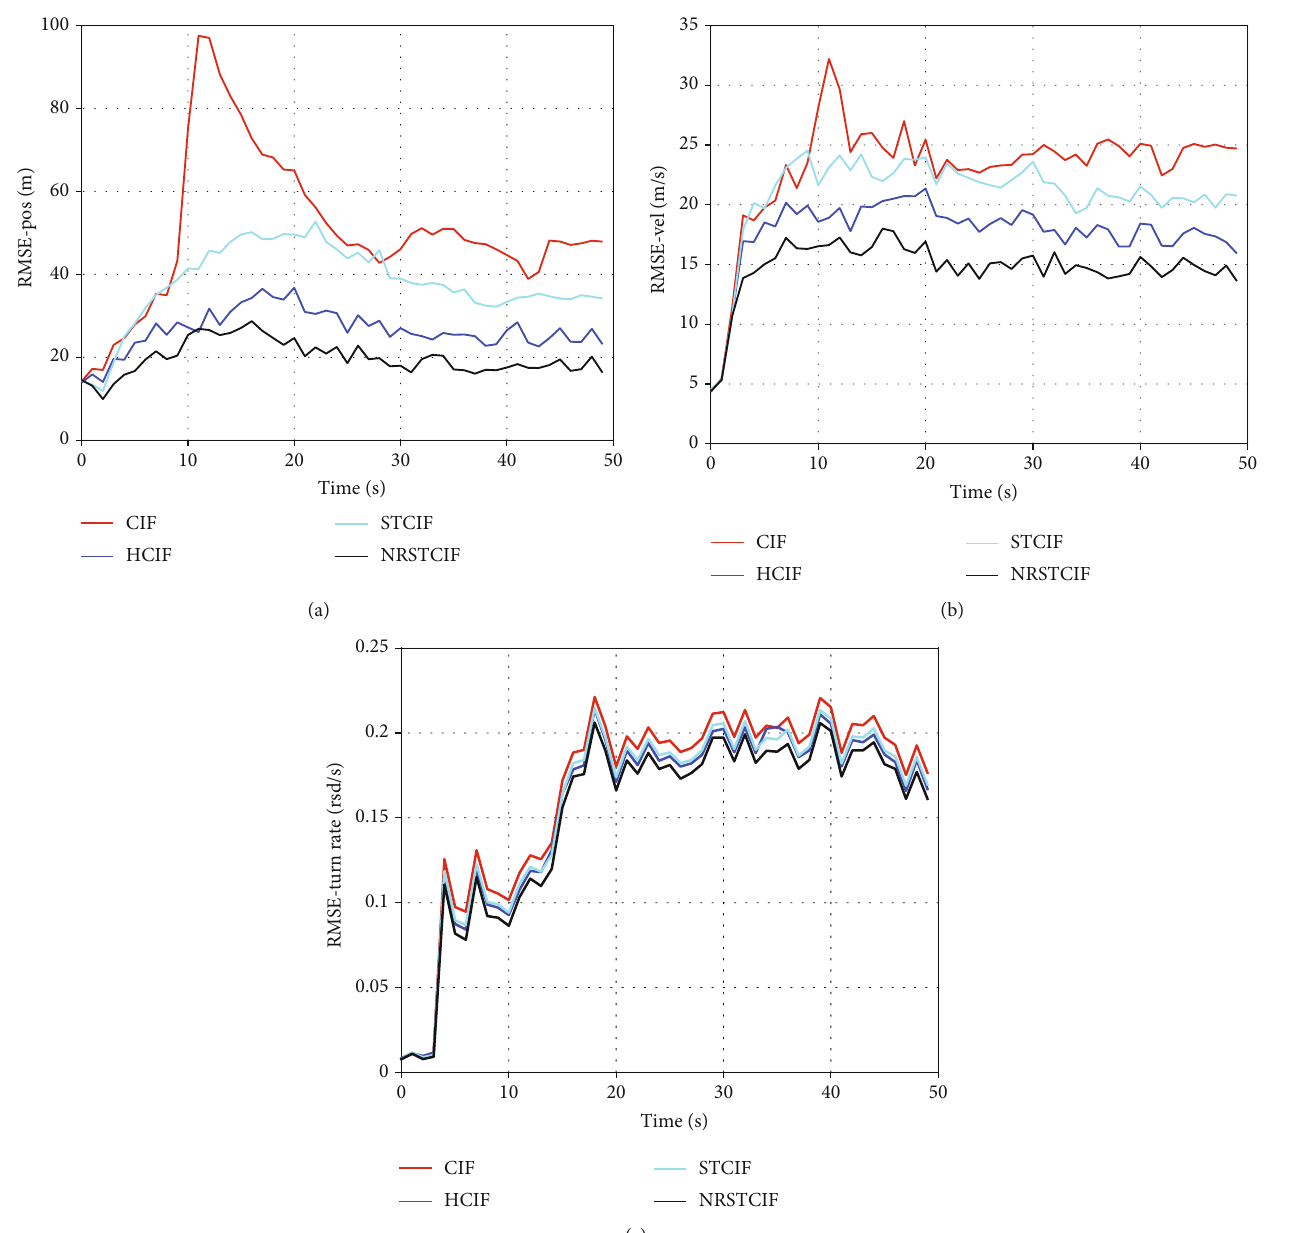
Figure 2: Tracking performance of four fi lters; (a) Position estimation error, (b) Velocity estimation error, (c) Turn rate estimation